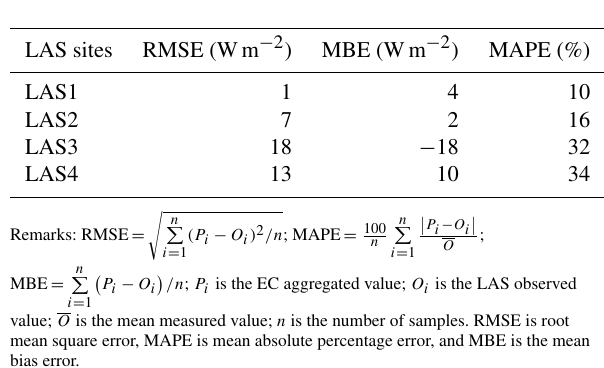
Table 3. Different statistics between LAS observed flux and EC aggregated flux at LAS